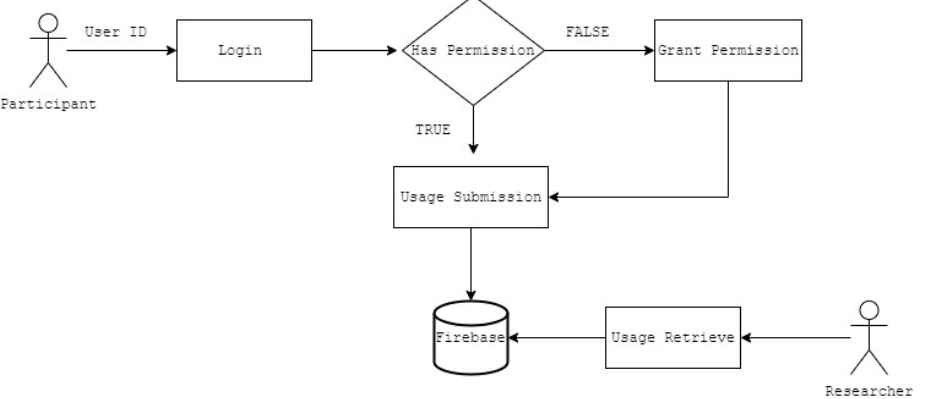
Figure 2. SocialStasApp Participant and Researcher workflow.